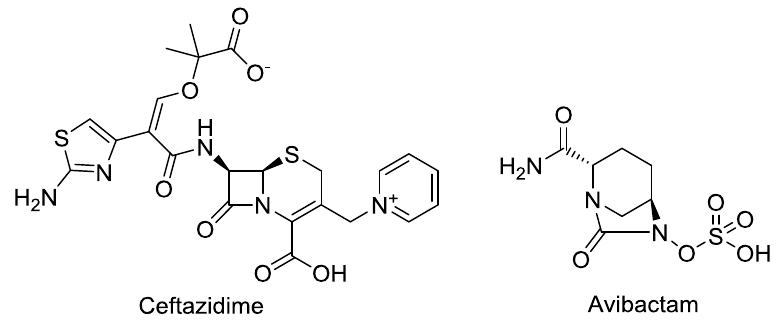
Figure 2. Chemical structure of CAZ104 and avibactam.